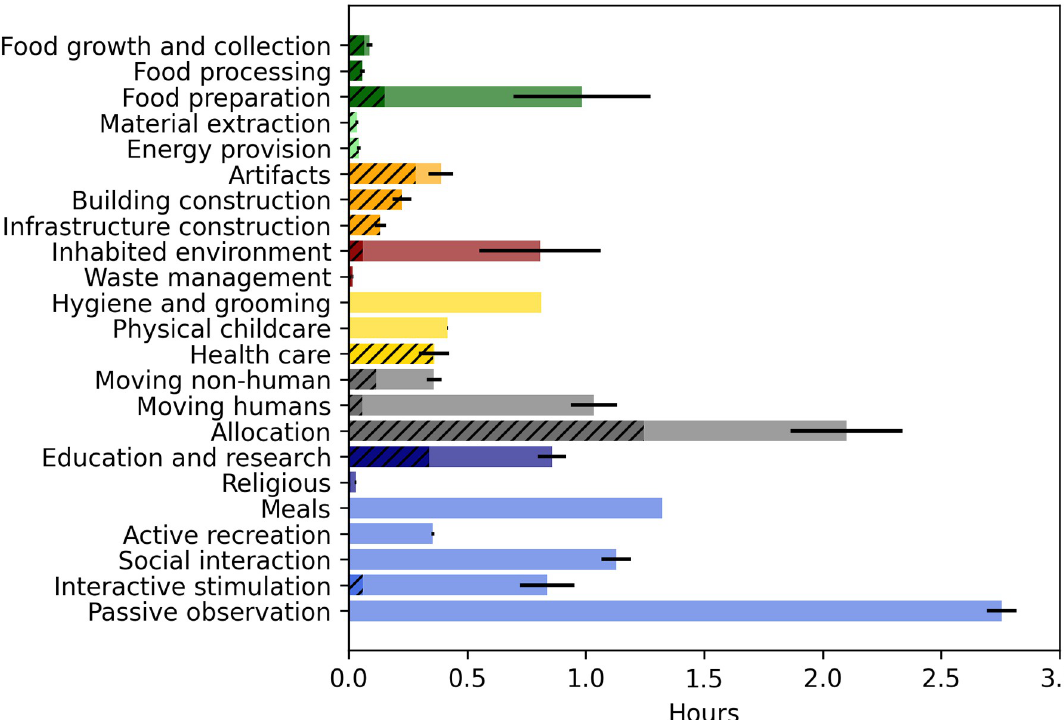
Fig 5. Time use in Canada using the MOOGAL. Combination of time use and economic activity data. Shaded bars show the total time allocated to each MOOGAL category, while hatched portions indicate the time allocated through the formal economy (work for pay or profit) Thin black lines indicate the 95% confidence range for the total time use in each MOOGAL category.